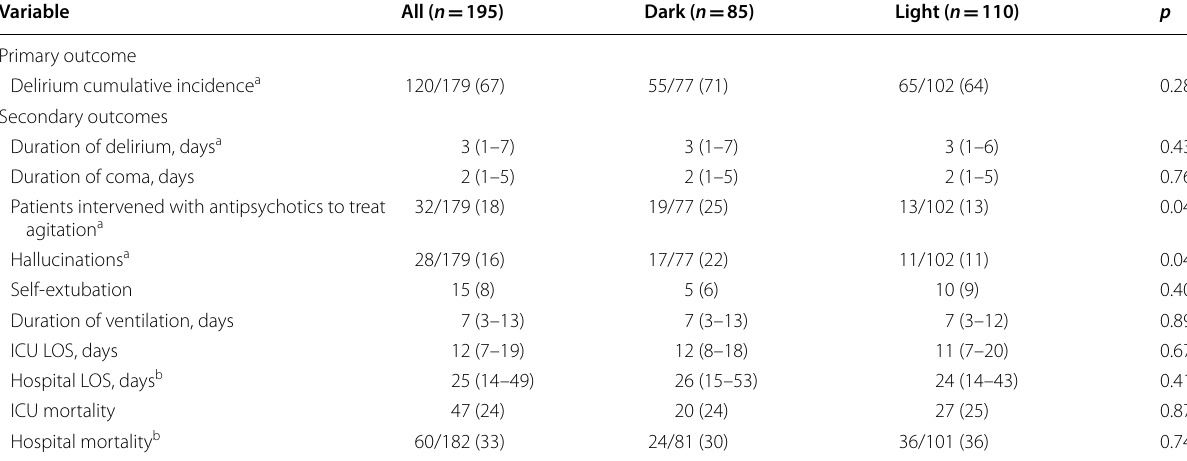
Data are median (interquartile range) or numbers (percentage) a 16 patients with coma during the whole ICU stay were excluded from analysis b